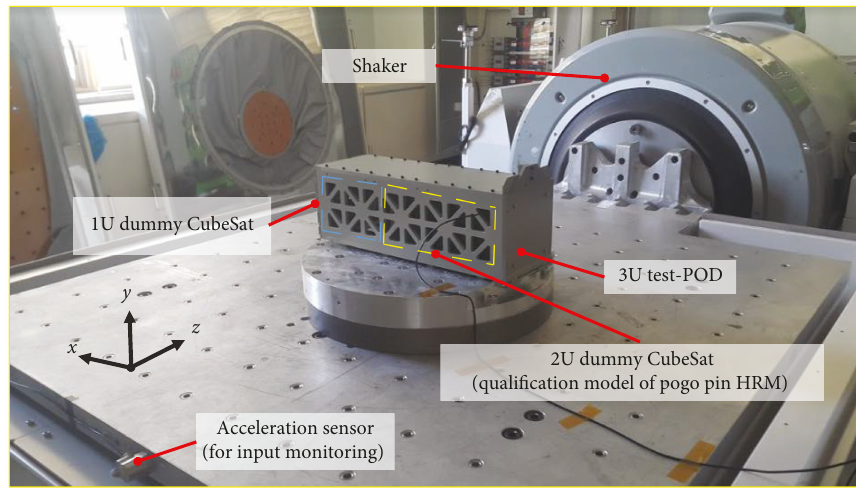
Figure 10: Example of vibration test setup of pogo pin HRM along the x -axis. Table 2: Speci fi cations of launch vibration test loads at quali fi cation